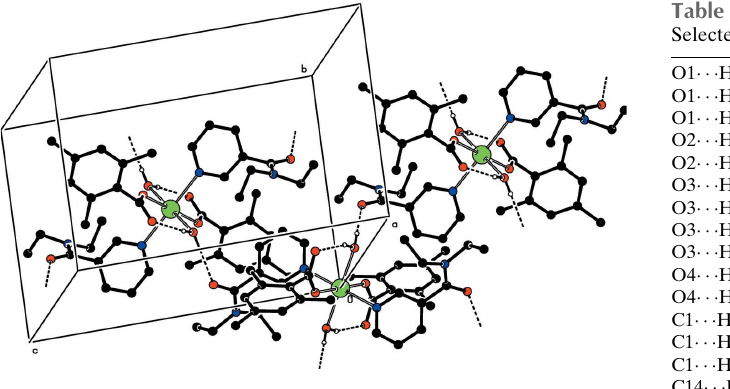
Figure 2 Part of the crystal structure. Only O—H W (cid:3)(cid:3)(cid:3) O TMB and O—H W (cid:3)(cid:3)(cid:3) O DENA (W = water, TMB = 2,4,6-trimethylbenzoate and DENA = N , N - diethylnicotinamide) hydrogen bonds, enclosing S (6) ring motifs, are shown as dashed lines. Only one part of the disordered group has been included and the C-bound hydrogen atoms have been omitted for clarity.